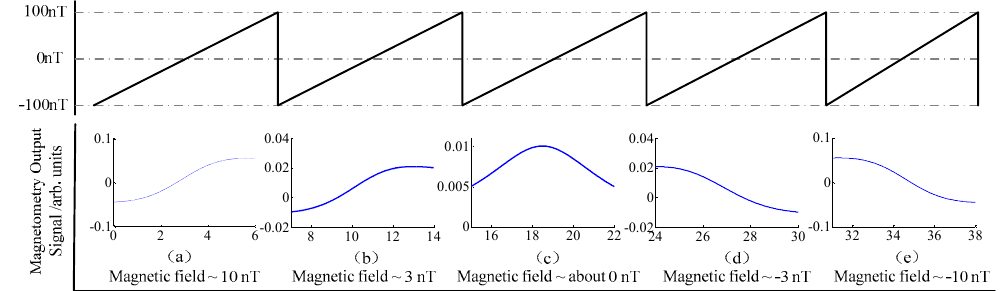
Figure 3. Simulation of the magnetic field compensation process. The magnetic field is changing from − 100 nT to 100 nT by scanning the sawtooth wave.